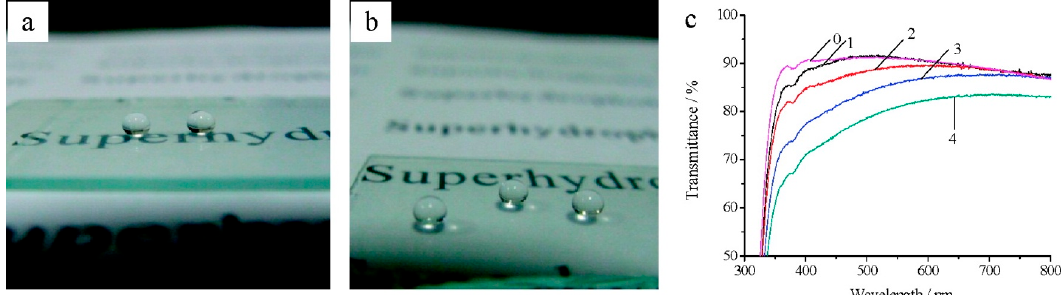
Figure 6. Digital photos of glass slides with superhydrophobic coatings prepared by dip-coating the APTS-modified HSPs: ( a ) APTS 0.70 wt % and ( b ) APTS 0.90 wt %. ( c ) Transmission spectra